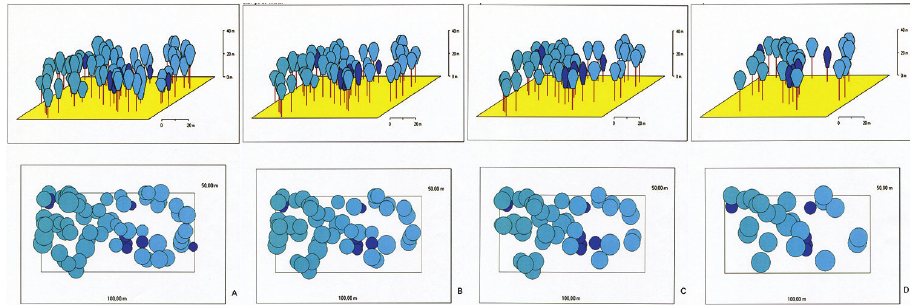
Figure 3. Growth simulation model for the Bucina pod Frantiskovou Myslivnou study site: current state ( A ) and future forest development for the periods of 25 years ( B ), 50 years ( C ), 80 years ( D ) (light blue: Fagus sylvatica , dark blue: Acer pseudoplatanus